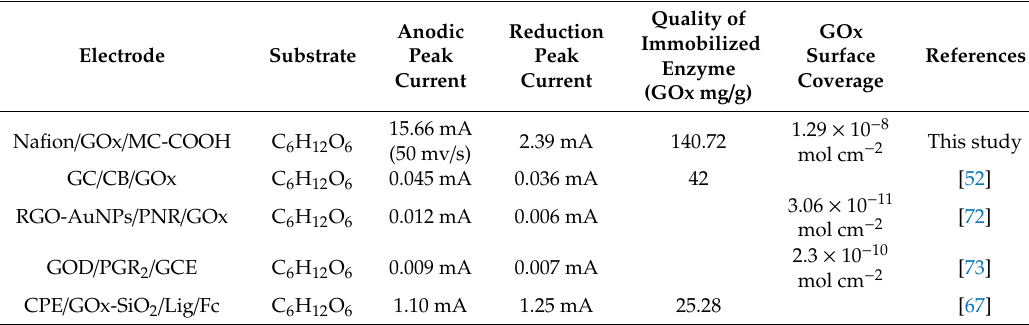
Table 3. Comparison between various GOx